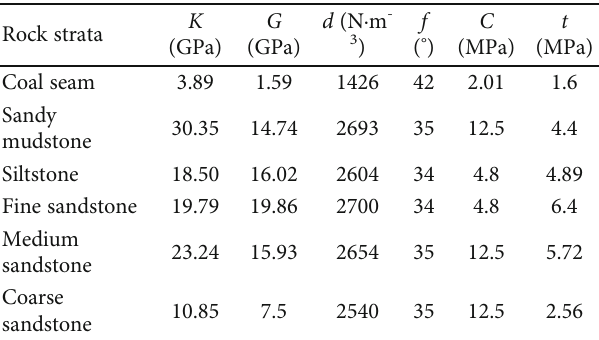
Figure 1: The numerical calculation model. Table 1: The physical parameters of rock mass.